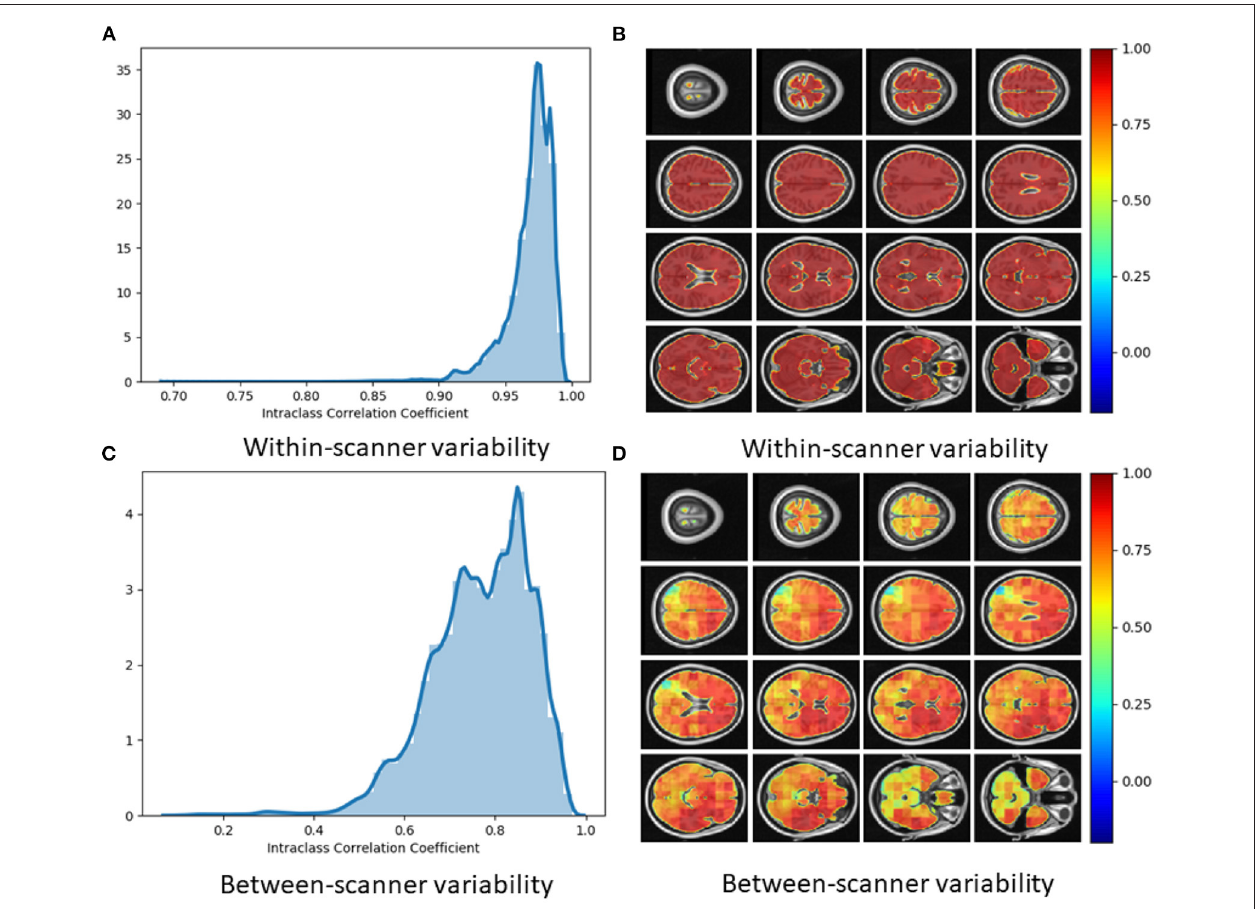
FIGURE 6 | (A) Histogram of Intraclass Correlation Coefficients computed at voxel-level on STORM dataset. Values above 0.9 indicate strong agreements. (B) ICC values at different views on the axial plane on test-retest (i.e., within-scanner) dataset ( n = 20). (C) Histogram of Intraclass Correlation Coefficients computed at voxel-level on between-scanner reliability dataset ( n = 11, Siemens and Philips scanners). (D) ICC values at different axial slices from the between-scanner